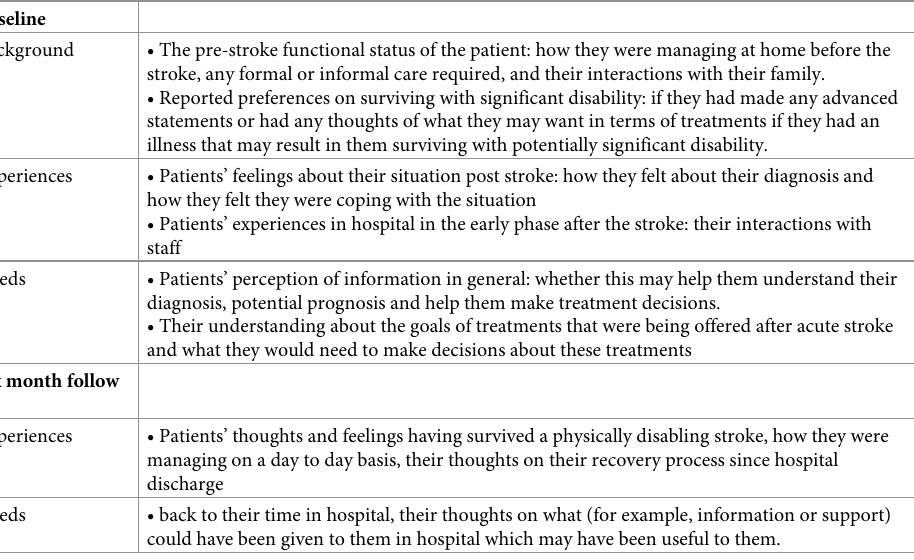
Table 1. Guide to the topics covered in patient